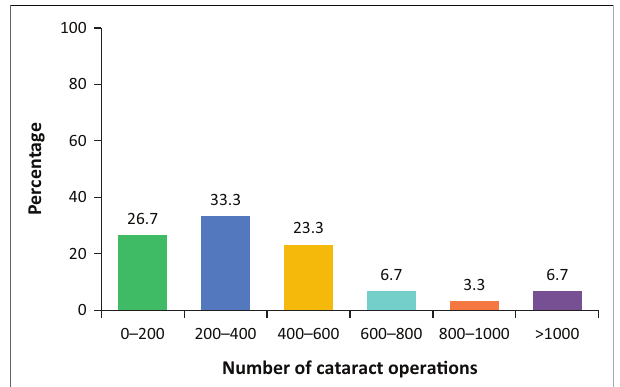
FIGURE 3: Number of cataract operations